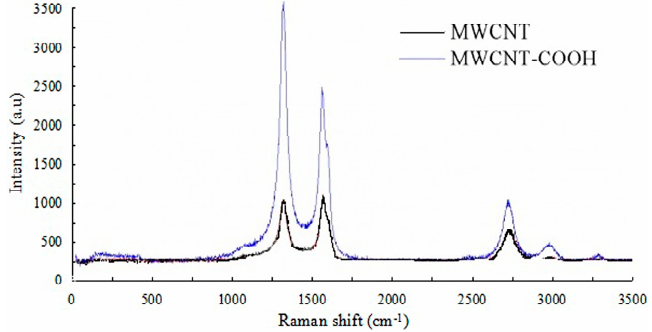
Figure 2. Raman spectra of multi-walled carbon nanotube (MWCNT) and MWCNT-COOH.